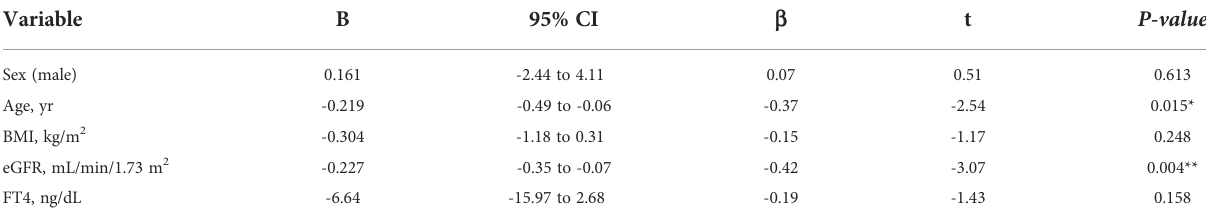
TABLE 6B Adjusted for sex, age, BMI, Post eGFR and FT4.